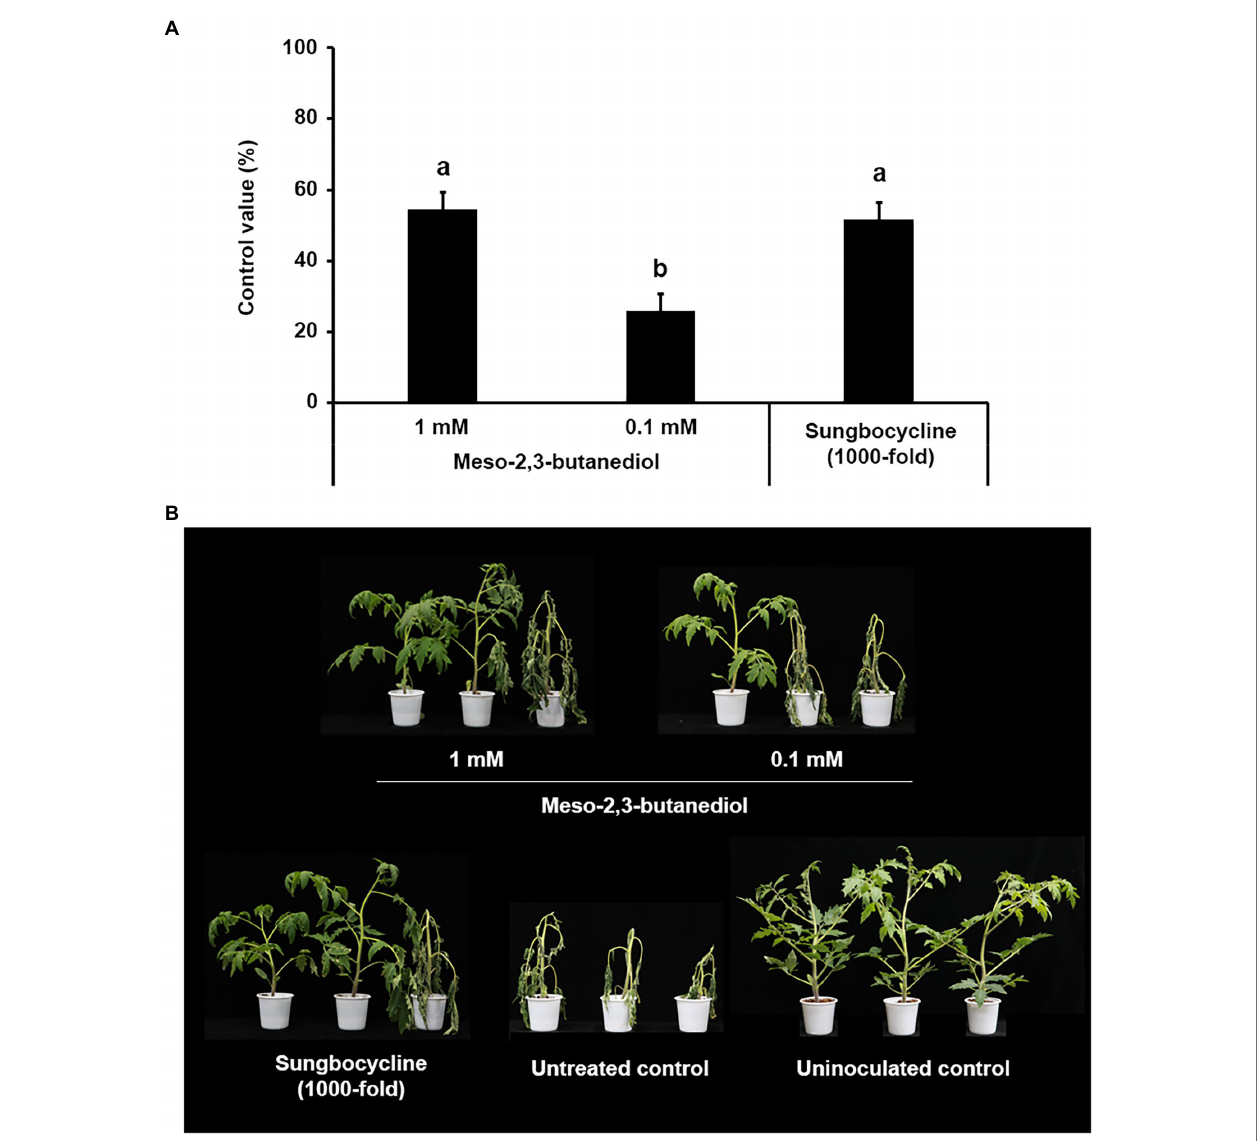
FIGURE 4 | Disease control efficacy of meso-2,3-BDO on tomato bacterial wilt caused by R. solanacearum . (A) Control value was investigated 7 days after pathogen inoculation. The data show the means ± SD ( n = 3). Lower-case letters indicate statistically significant differences as compared to untreated control plants ( p < 0.05) according to Tukey’s HSD test. Error bars indicate the SDs. (B) Representative photographs of tomato seedlings at 7 days after inoculation of R. solanacearum by soil drench. As a positive control, plants were treated with